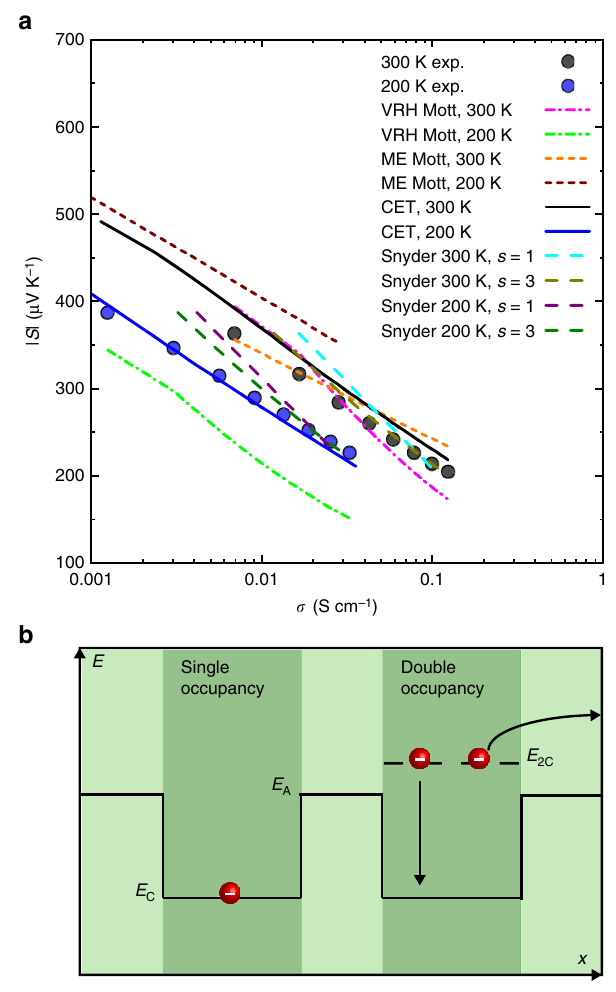
Fig. 4 Seebeck coef fi cient S versus conductivity σ as well as Coulomb enhanced charge transport (CET) model illustration. The measured Seebeck coef fi cient versus conductivity of the 200 °C annealed device at 300 and 200 K, as well as the fi ts of different transport models are shown in the top ( a ) 7,21,31,32 . The fi tting parameters for the CET model (solid black and solid blue line) 21 are the same as in Fig. 3. For the fi ts with Snyder and coworkers model the following conductivity prefactors were used: σ 0 = 0.151 S cm − 1 ( s = 1, 300 K, turquoise dashed line), σ 0 = 2.2 mS cm − 1 ( s = 3, 300 K, olive dashed line), σ 0 = 0.051 S cm − 1 ( s = 1, 200 K, purple dashed line) and σ 0 = 0.82 mS cm − 1 ( s = 3, 200 K, dark green dashed line). For the fi ts with the VRH Mott model the following parameters were used: γ = 1/3 and ξ d = 6.15387 nV K − 2 (pink and green dashed dotted lines). A = 0 has been used for the ME Mott fi ts (orange and dark red dashed lines). The bottom ( b ) illustrates the two key processes of the CET model. The fi rst process is exempli fi ed as having single independent electrons in a crystalline domain and the second process of two charges in a crystalline domain raised in energy due to their Coulomb